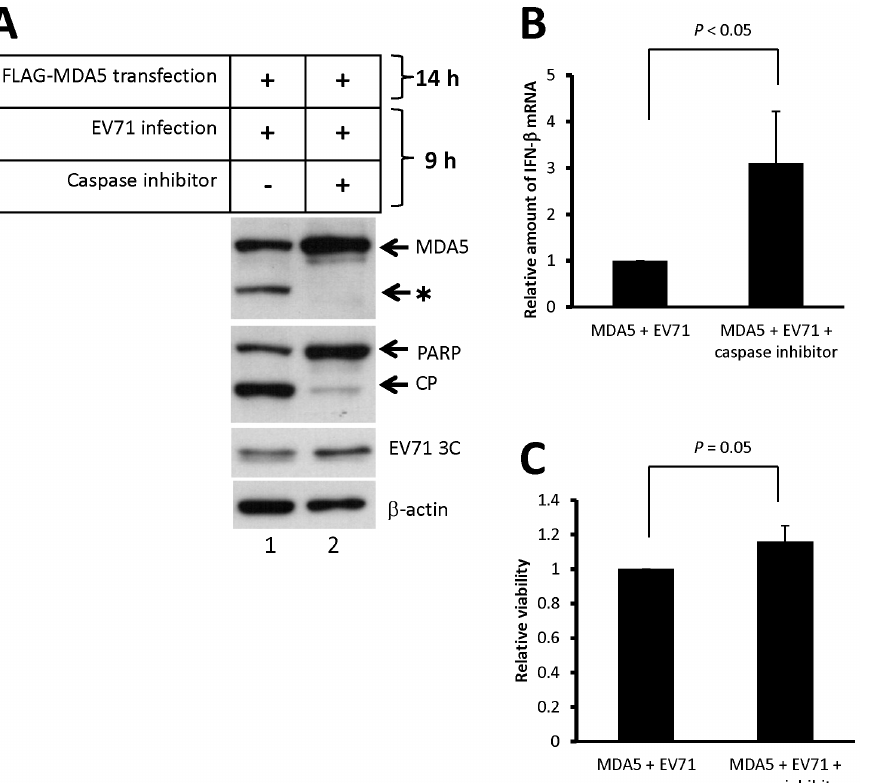
Figure 7. Examining the effect of caspase-dependent MDA5 cleavage on IFN- b mRNA production upon EV71 infection. HeLa cells were transfected with a plasmid expressing the FLAG-MDA5 for 14 h The transfected cells were subsequently infected with EV71/MP4 strain in presence or absence of a broad spectrum caspase inhibitor, Q-VD-OPH, at final concentration of 20 nM. Cell extracts and total RNA were collected at 9 h post-infection. The cell extracts were assayed by immunoblotting using anti-MDA5, anti-PARP, anti-V71 3C, and anti- b -actin antibodies (A). Relative amount of IFN- b mRNA in the cells was measured by real-time RT-PCR (B). (C) MTT assay was performed to determine the relative cell viability.